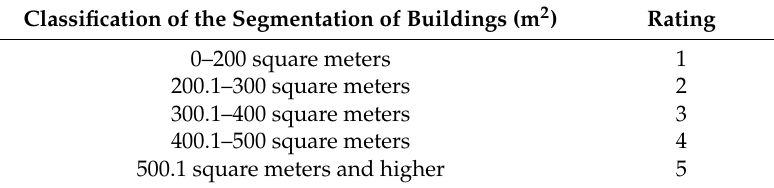
Table 5. Rating the segmentation of buildings.